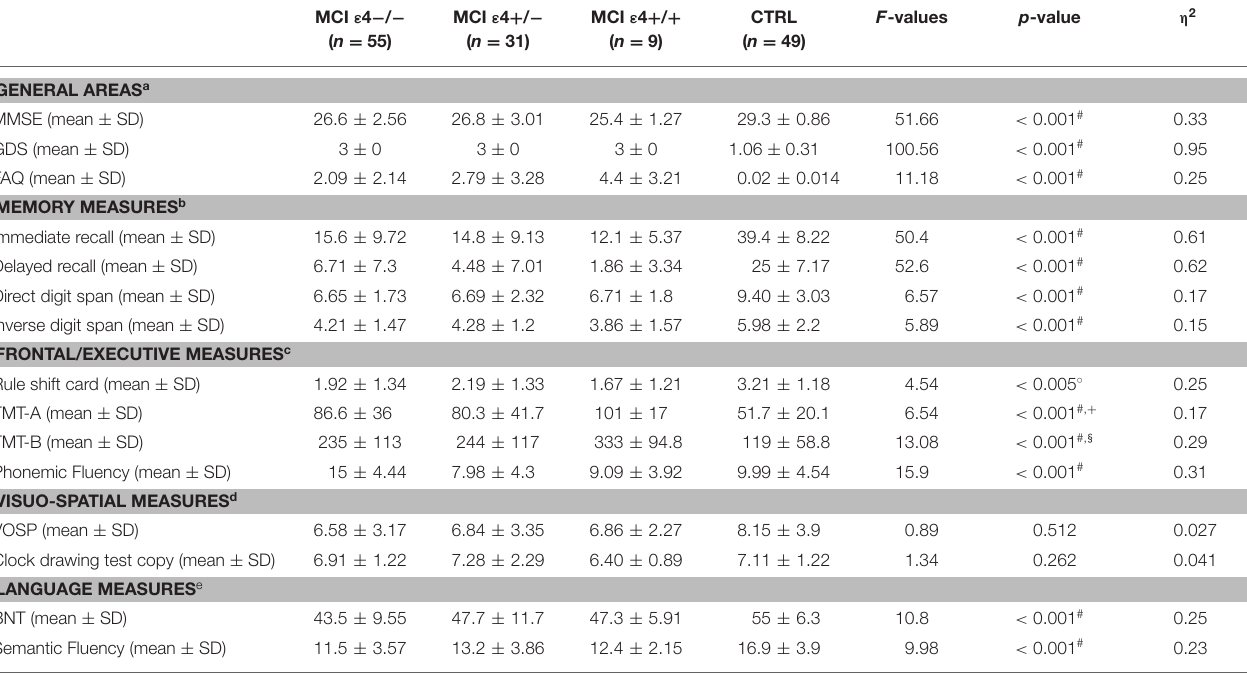
TABLE 2 | Neuropsychological scores in MCI patients and healthy